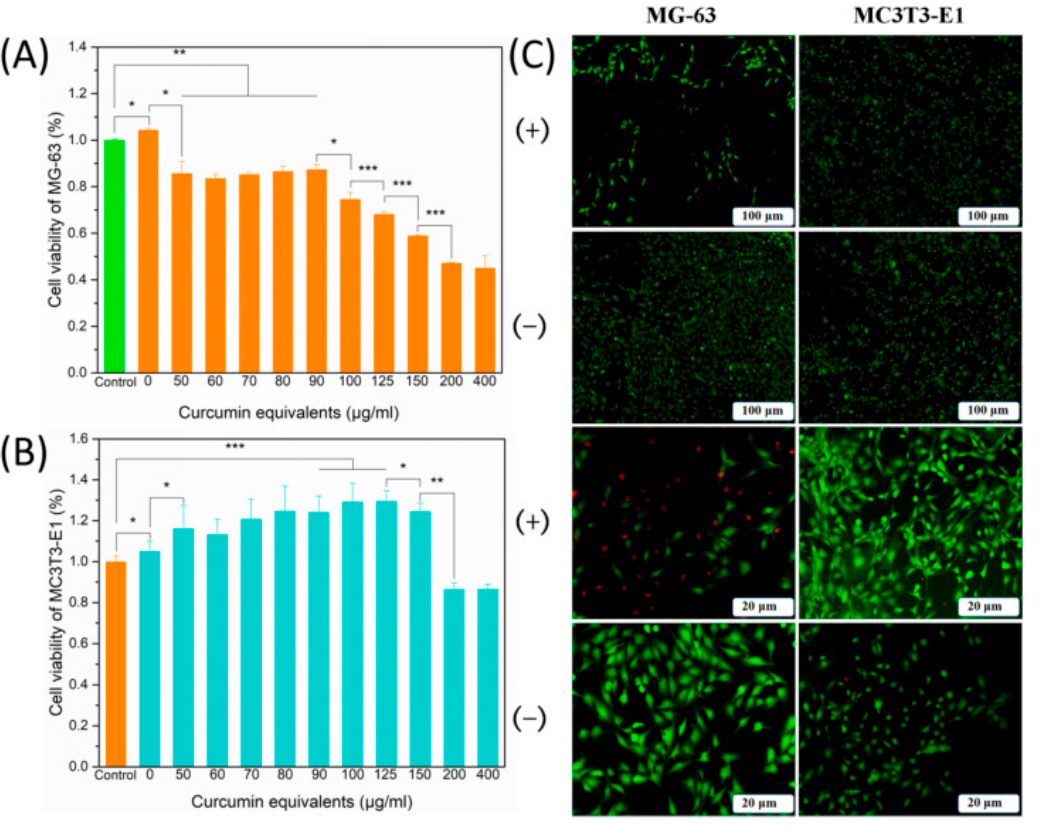
Figure 4. ( A ) Cell viability of MG-63 osteosarcoma cells when exposed to curcumin (Cur). ( B ) Cell viability of MC3T3-E1 pre-osteoblasts when exposed to Cur. ( C ) Live and dead images of MG-63 and MC3T3-E1 cells exposed to curcumin-loaded scaffolds (+) and without ( − ). * p < 0.05, ** p < 0.01, *** p < 0.001. Reprinted with permission from [94].